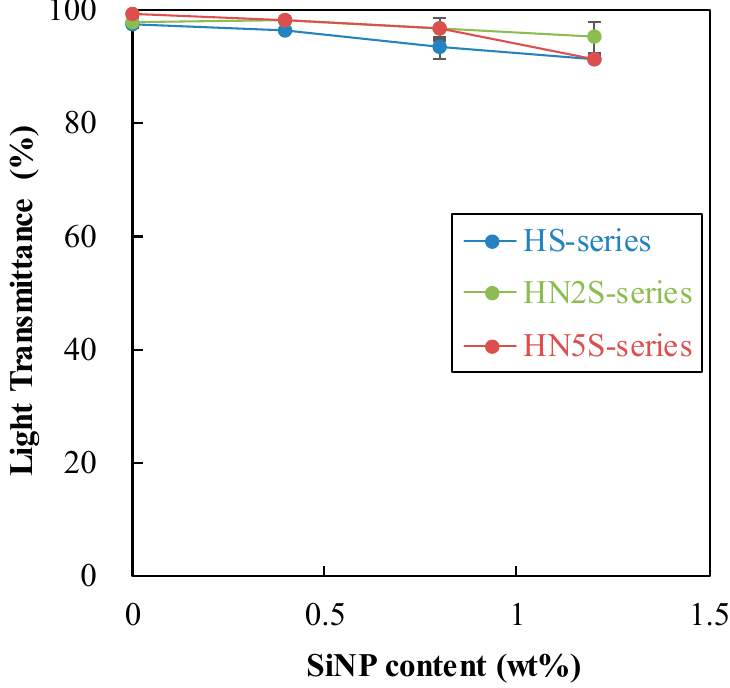
Figure 9. Light transmittance of SiNPs samples.